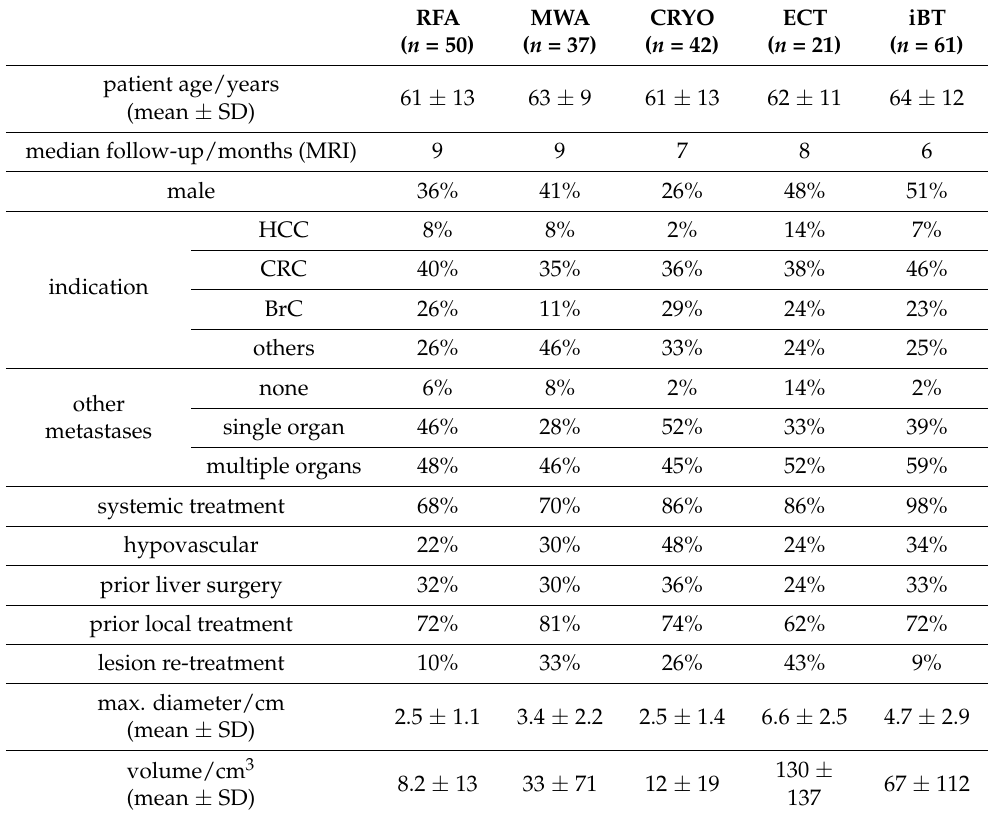
Table 1. Demographic characteristics and aetiology of the treated malignancies, presence of mul- tiorgan metastases, and characteristics of the target lesions summarised in a table and sorted by ablation